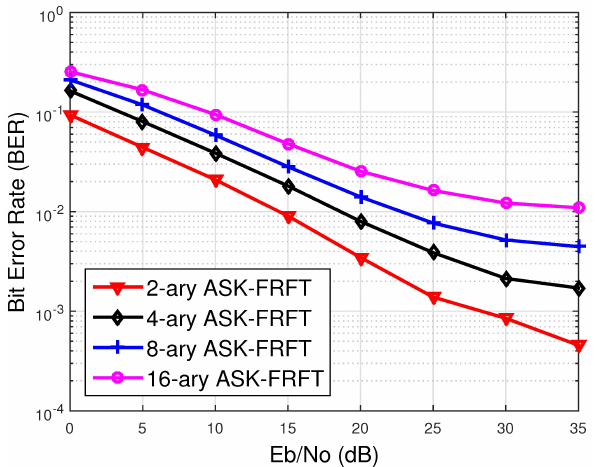
Fig. 7 Comparison of bit error rate between FRFT and FFT based on the limiting algorithm. FFT, fast Fourier transform; FRFT, fractional Fourier